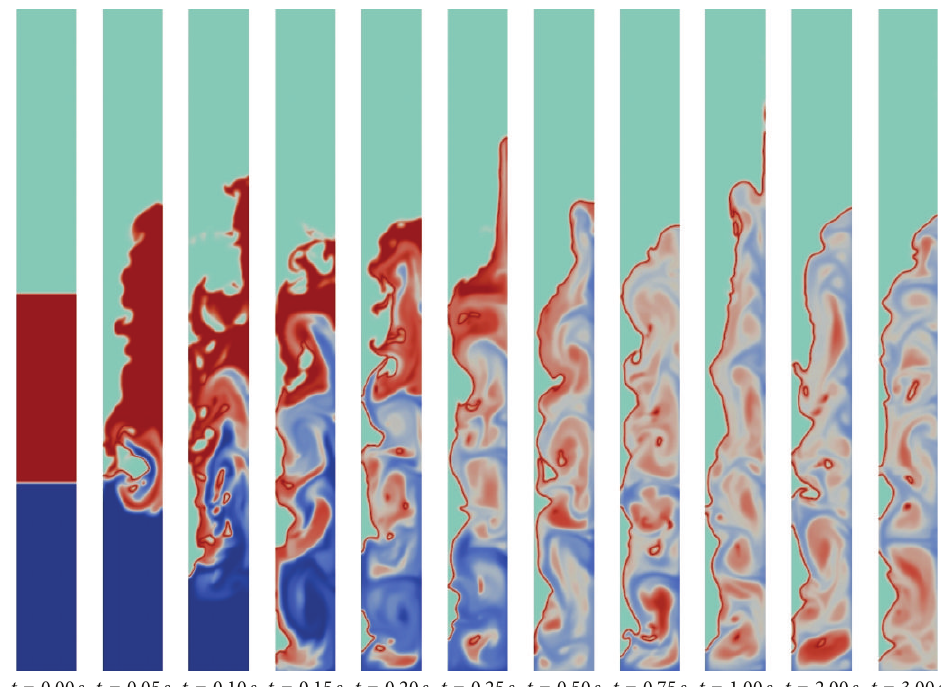
Figure 7: Sequence of snapshots of phase fraction for water (blue), oil (red), and air (cyan) in the 2D axisymmetric annular mixer geometry at 3600